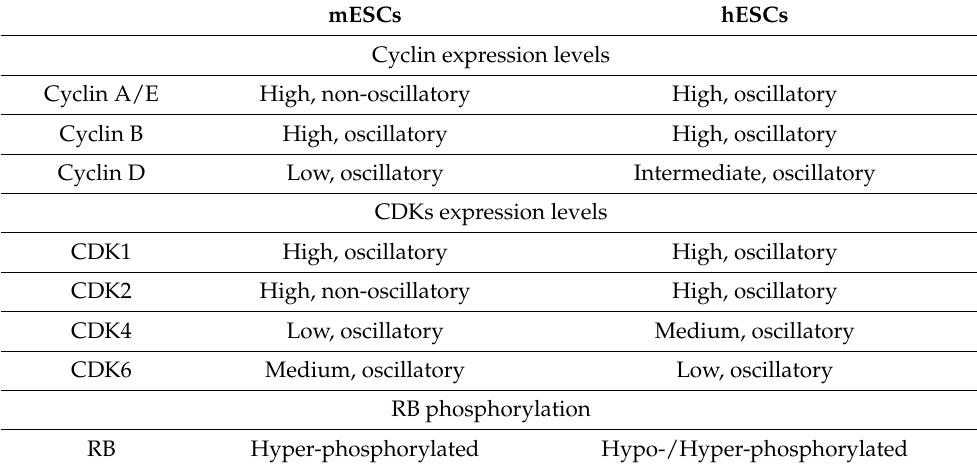
Table 1. Expression levels of cyclins, cyclin-dependent kinases (CDKs) and phosphorylation status of retinoblastoma protein (RB) in mESCs and hESCs during cell cycle progression. mESCs hESCs Cyclin expression levels Cyclin A/E High, non-oscillatory High, oscillatory Cyclin B High, oscillatory High, oscillatory Cyclin D Low, oscillatory Intermediate, oscillatory CDKs expression levels CDK1 High, oscillatory High, oscillatory CDK2 High, non-oscillatory High,